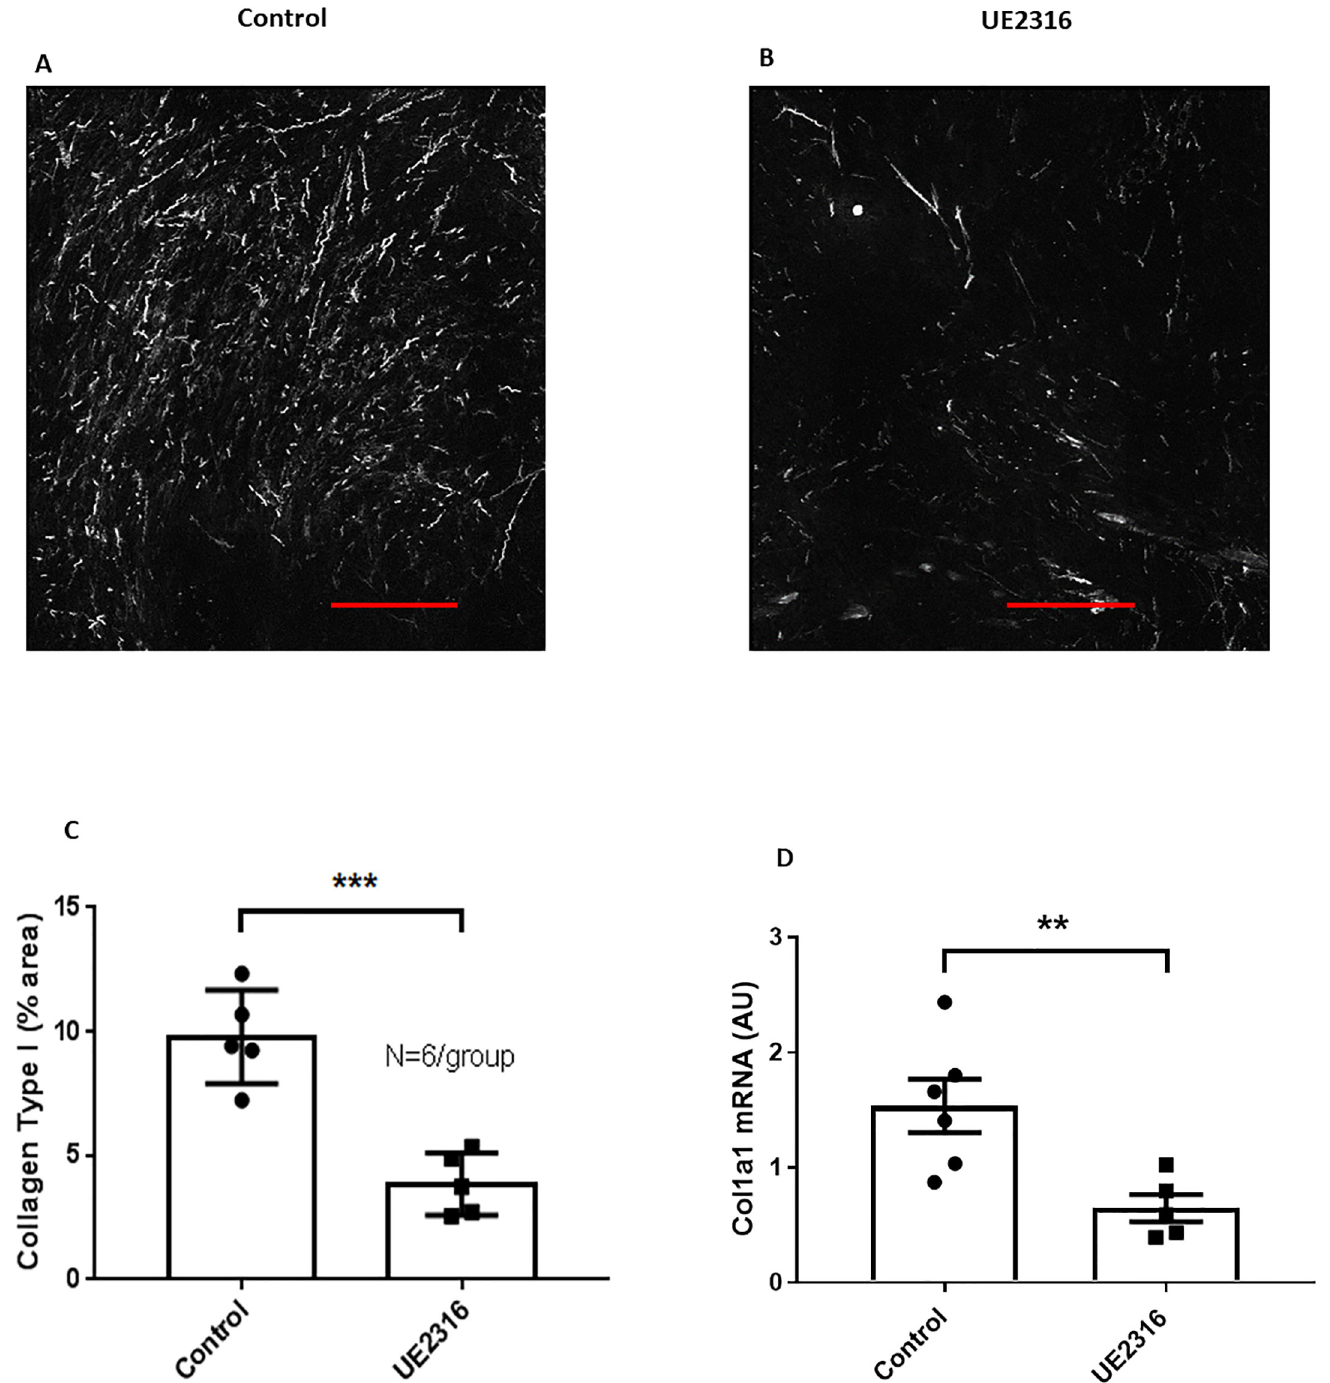
Fig 6. Type I collagen is reduced in SCC tumours from UE2316-treated mice. Second Harmonic Generation imaging showed type I collagen (white signal) in SCC tumours from UE2316-treated (B) and control mice (A). Scale bar = 100 μ m. C) Type I collagen was reduced in tumours from UE2316-treated mice. ��� P < 0.001. N = 5/group. D) Col1a1 mRNA was reduced in SCC tumours from UE2316-treated mice compared to control mice. AU = Arbitrary units. �� P < 0.01. N = 5-6/group. Data were compared by independent samples t-test.